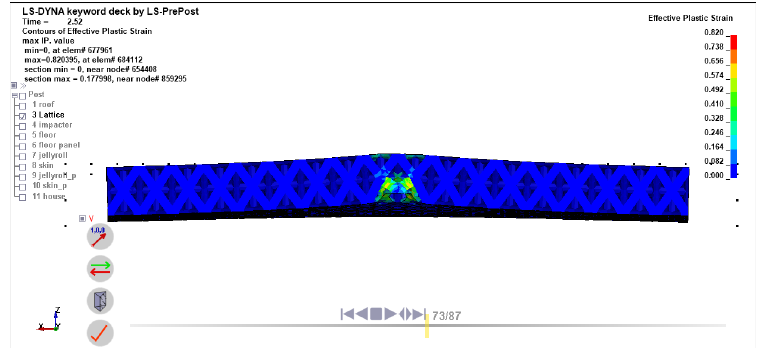
Figure 20. Plastic Deformation of The Configuration #1 Lattice Structure.